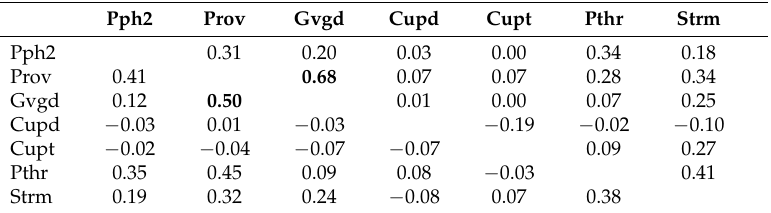
Table 3. The inner consistency results for Spearman’s correlation coefficient. The elements above the diagonal correspond to the BRCA1-SGE dataset while the elements below it correspond to the BRCA1-HDR dataset.